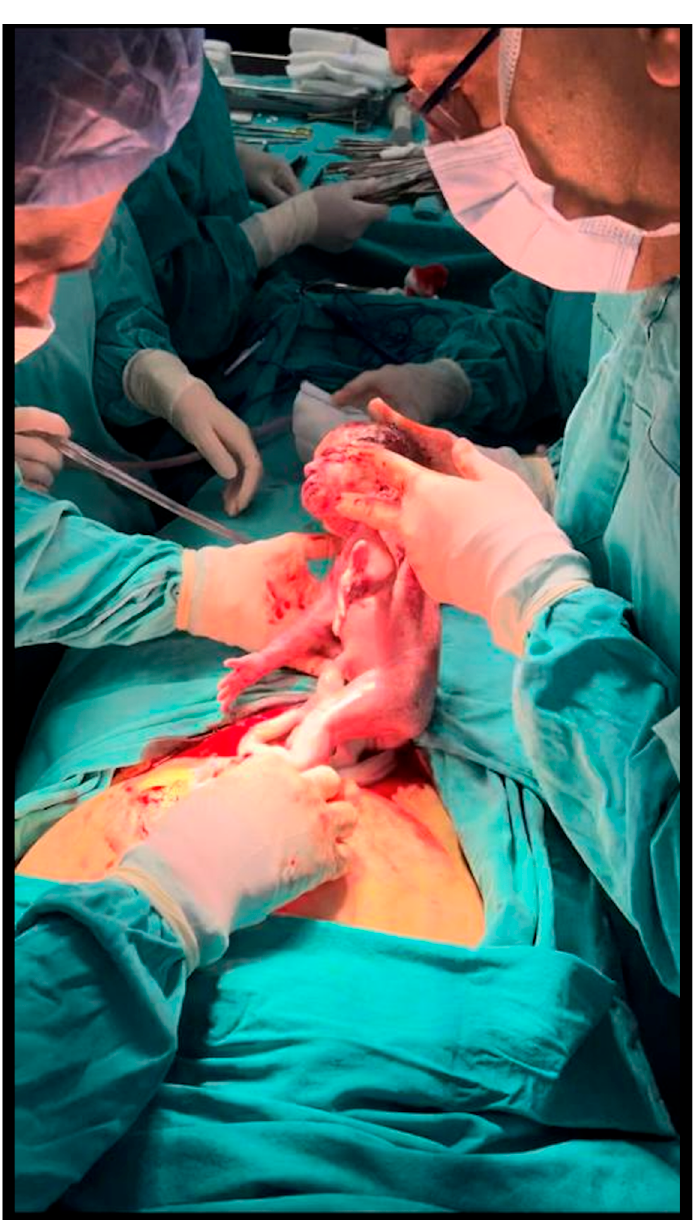
Figure 7. Birth of the second baby from the second uterus transplantation in Turkey.